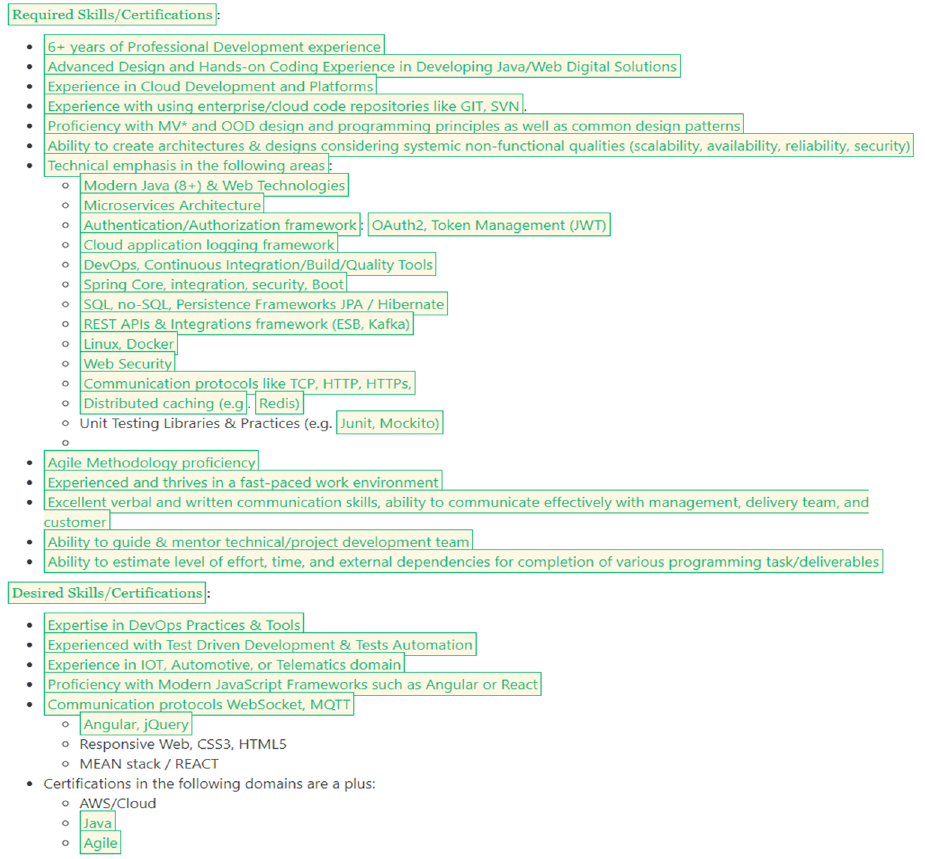
Figure 13. Part of a job advertisement processed by the method called machine learning with mark- ing of sentences between positive